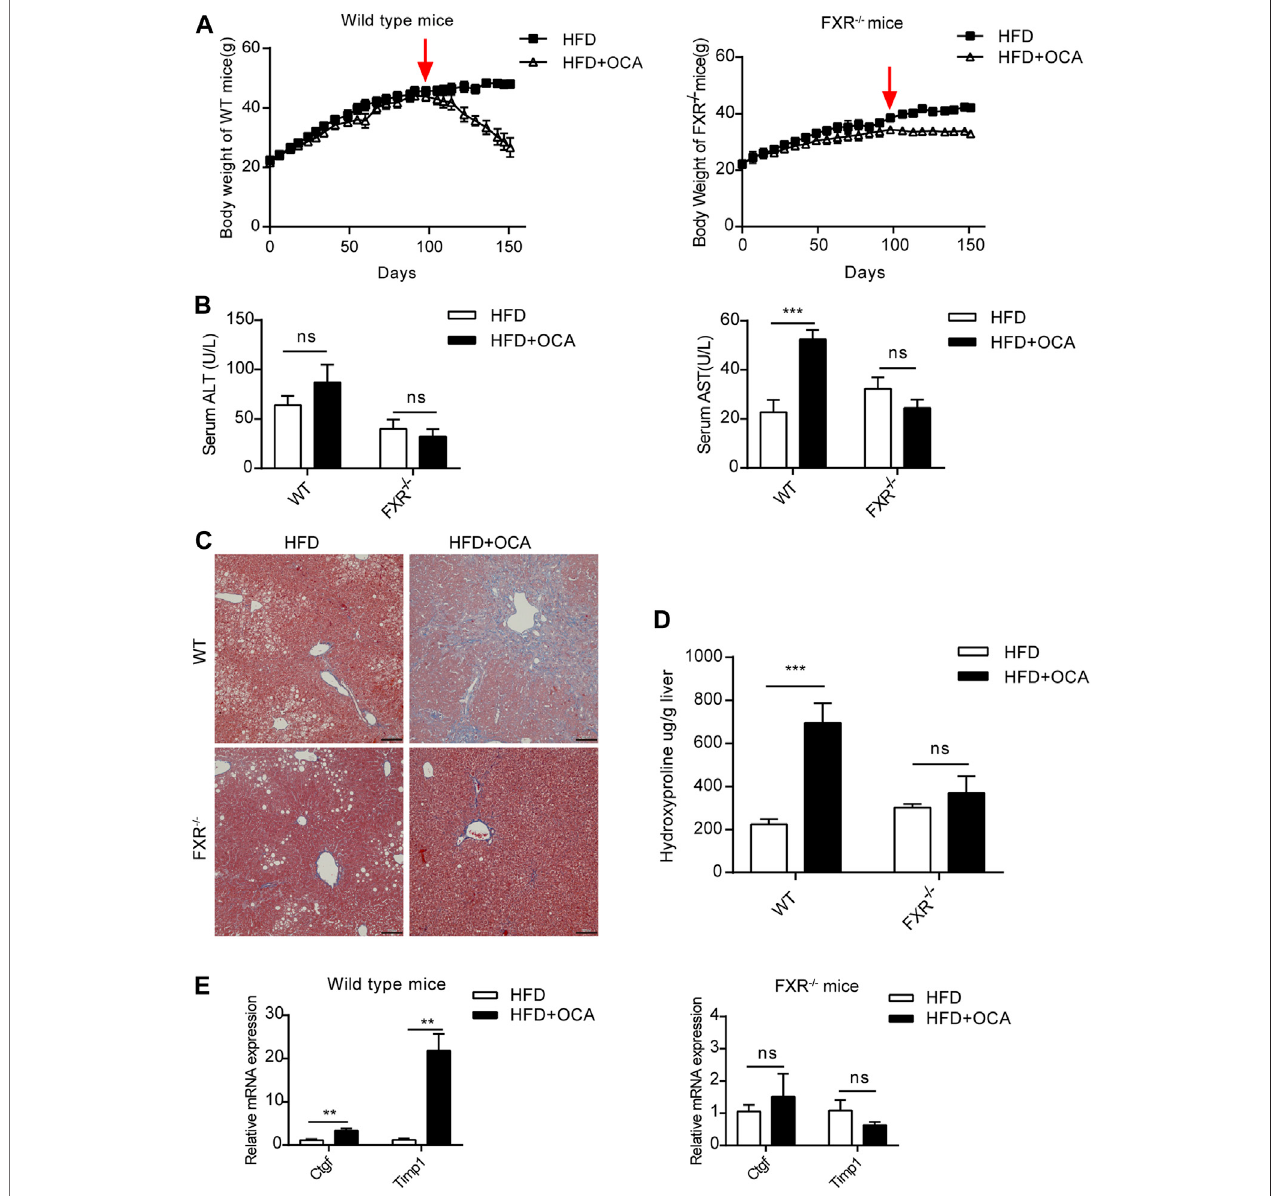
FIGURE 2 | High-dose OCA caused hepatic fi brosis and hepatic stellate cell activation in the presence of FXR. Mice were administered with a high-fat diet supplemented with0.04%OCA for14weeks,after whichmice received ahigh-fatdiet containingahighdose ofOCA (0.16%, red arrows) for8weeks( n =3 – 6). (A) Left panel,bodyweightofWTmice;rightpanel,bodyweightofFXR − / − mice. (B) SerumparametersofWTmiceandFXR − / − mice. (C) Masson ’